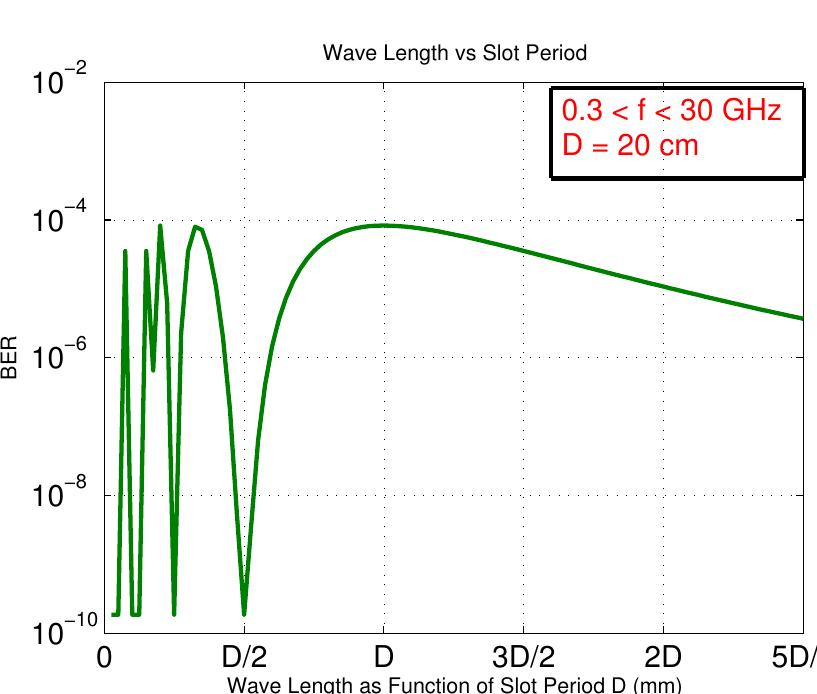
Figure 7. BER of LF with the wave